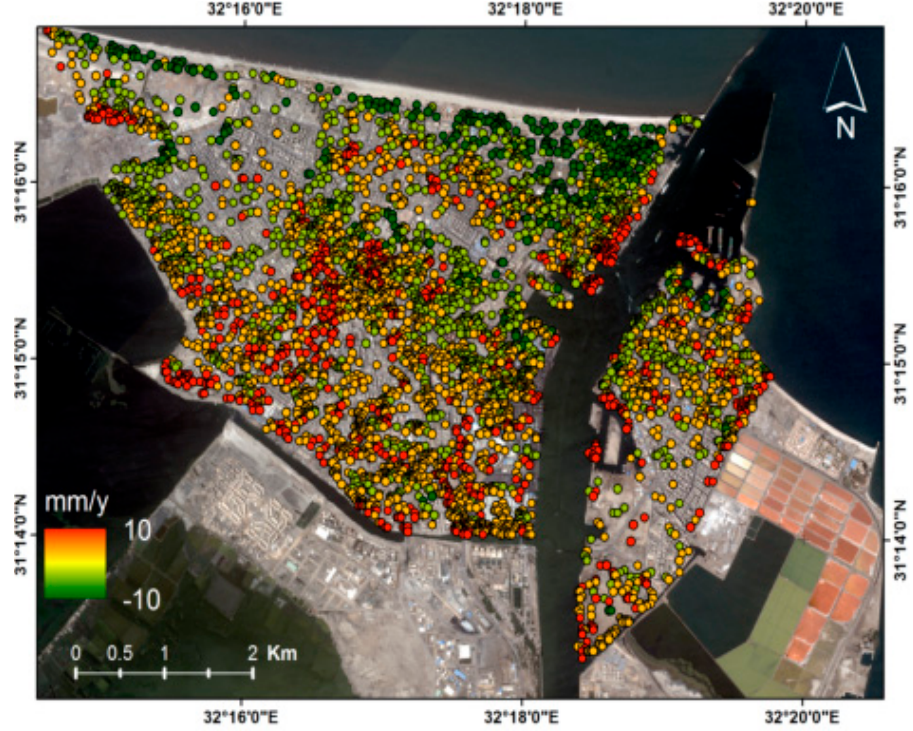
Figure 15. The average vertical ground motion velocities from 2007 to 2010 of pixels with coherence threshold ≥ 0.3.